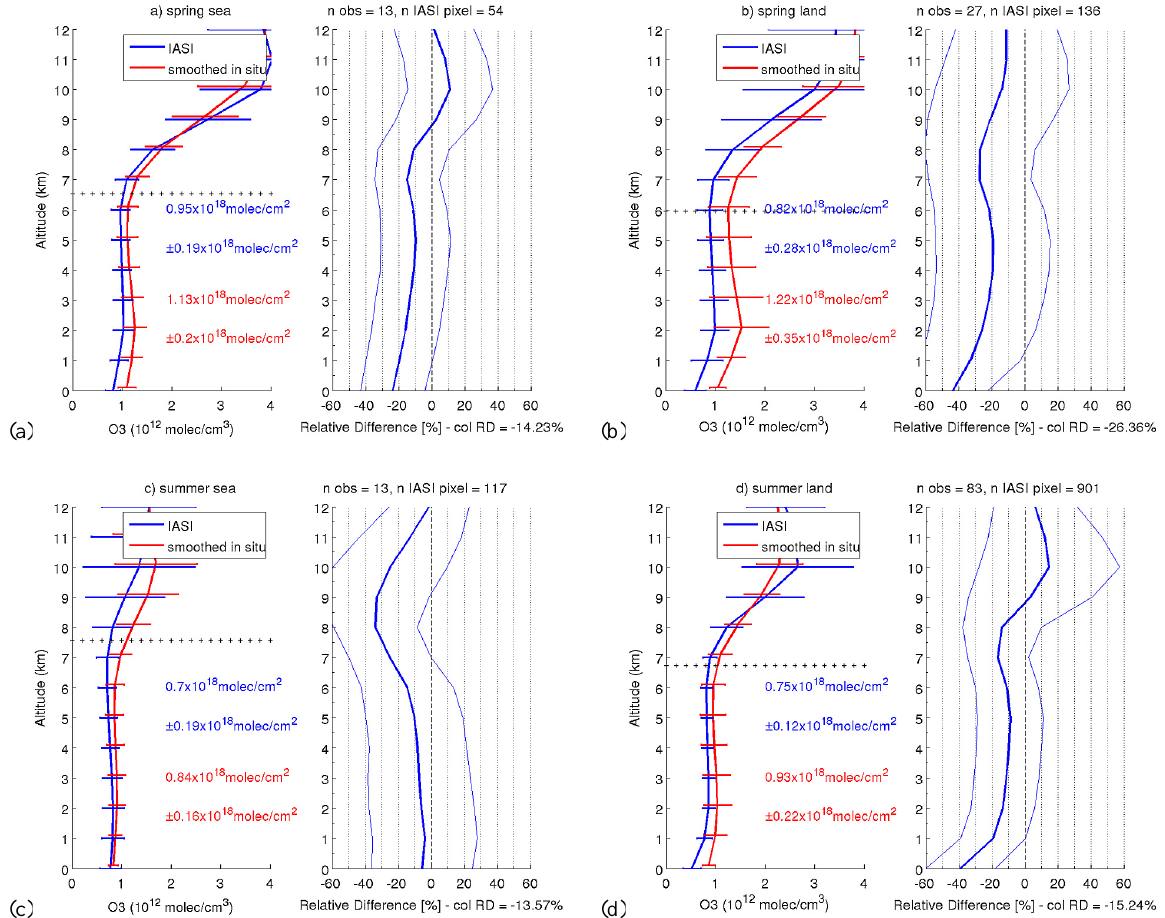
Fig. 9. Left panel: average IASI O 3 profiles (blue lines) and smoothed in situ profiles (red lines) in units of 10 12 moleculescm − 3 for spring (top panels) and summer (bottom panels), over sea (a) and (c) and land (b) and (d) . The horizontal dashed black line represents the mean position of the maximum altitude reached by each particular aircraft. Error bars represent the variability of averaged smoothed data (standard deviation ± 1 σ) . The coloured numbers indicate the average [0–8km] columns in 10 17 moleculescm − 2 and the standard deviation. Right panel: average relative differences (RD) in % (thick blue lines for profiles and numbers below the graphs on the right are the average differences for [0–8km] columns) and ± 1 σ (thin blue lines) are also plotted as a function of altitude. The number of in situ observations and IASI co-located pixels are noted at the top right of the panels. The mean ECMWF dynamical tropopause is at 7.8, 8.2, 10.4 and 9.5km,